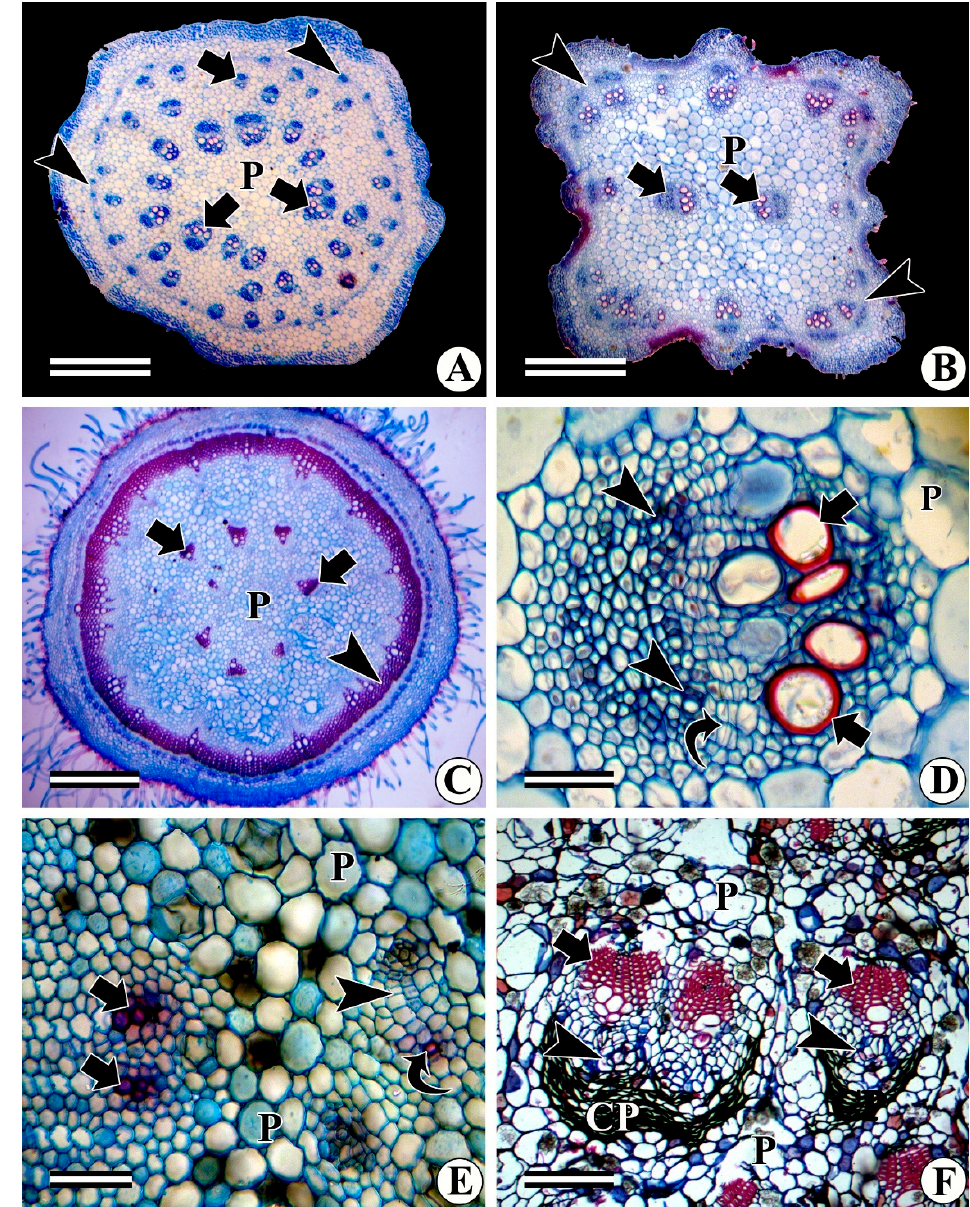
Figure 13. Transverse view of young and mature stems showing medullary bundles in different species of eudicots. ( A ) Young stem of Amaranthus spinosus showing several medullary bundles (arrows) in the pith region. Note the initiation of the vascular cambial ring (arrowheads). ( B ) Young stem of Achyranthes aspera showing only two medullary bundles (arrows). Arrowheads indicate initi- ation of the regular vascular cambium. ( C ) Young stem of Argyreia nervosa showing a few medullary bundles (arrows). Arrowhead shows a well-established ring of secondary xylem. ( D ) Enlarged view of one of the medullary bundles in Achyranthes aspera showing the structure and composition of the medullary bundle. Note the phloem (arrowhead), protoxylem (arrow), and procambium (curved arrow). ( E ) Simultaneous origin of protoxylem (arrows) and the medullary bundles (curved arrow) in Argyreia nervosa . Arrowhead indicates the cambial segment of the medullary bundle. Note the ab- sence of intraxylary protophloem between the protoxylem and the medullary bundles. ( F ) Secondary growth in the medullary bundles of A. nervosa showing a quantifiable amount of secondary xylem (arrows) and phloem (arrowheads). Note the crushed phloem. Abbreviations : CP = crushed phloem, P = pith. Scale bars : ( A – C ) = 500 µ m, ( D , E ) = 50 µ m, ( F ) = 200 µ